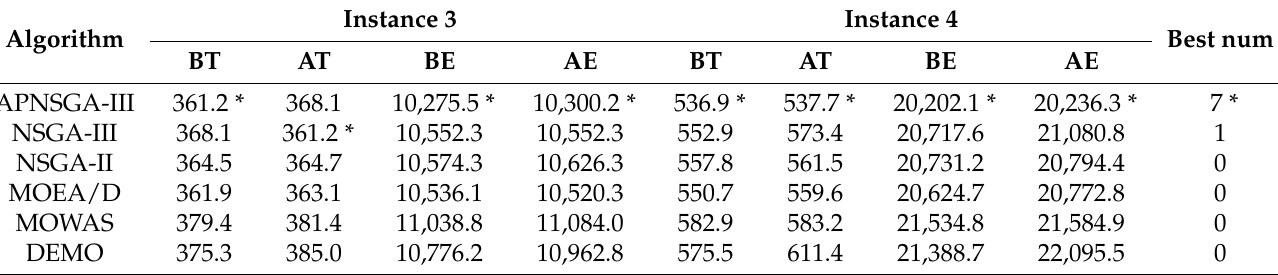
Table 12. The results of Instance 3 and Instance 4 (* represents the optimal